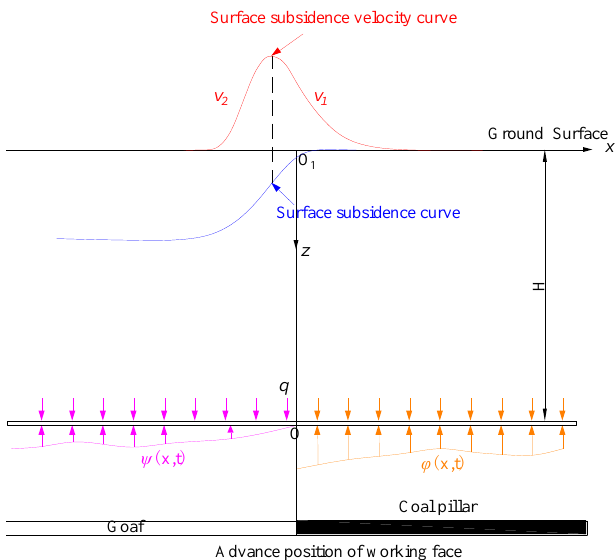
Figure 3. Schematic diagram of skewness distribution of dynamic subsidence.